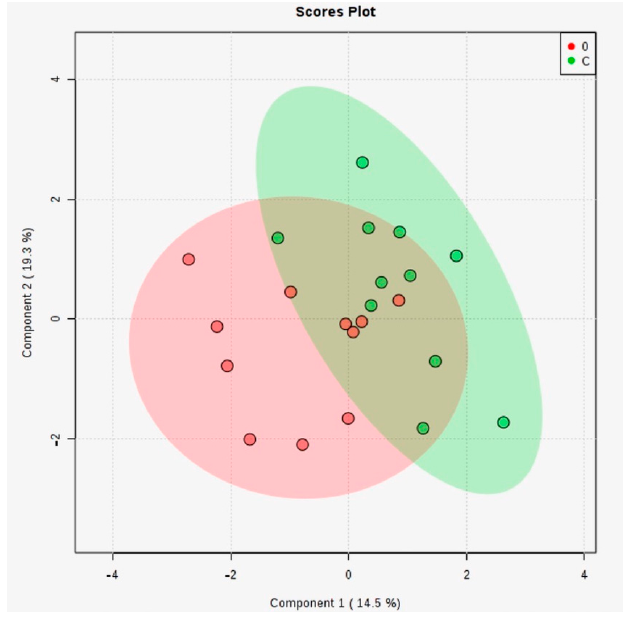
Figure 1. 2D score plots of PLS-DA analysis for control groups (C) vs. MDD1 (code 0).